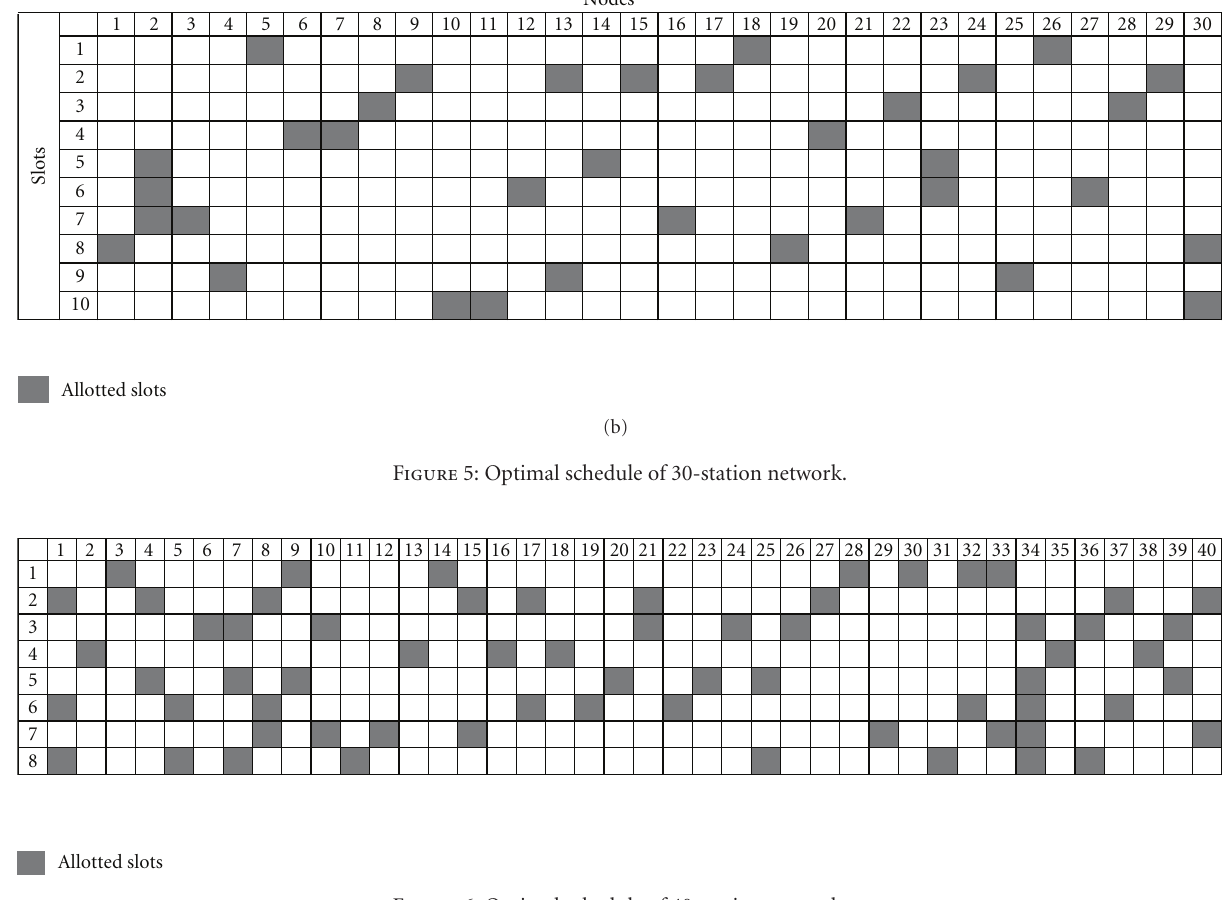
Figure 6: Optimal schedule of 40-station network. Table 7: Comparison of average time delay and number of